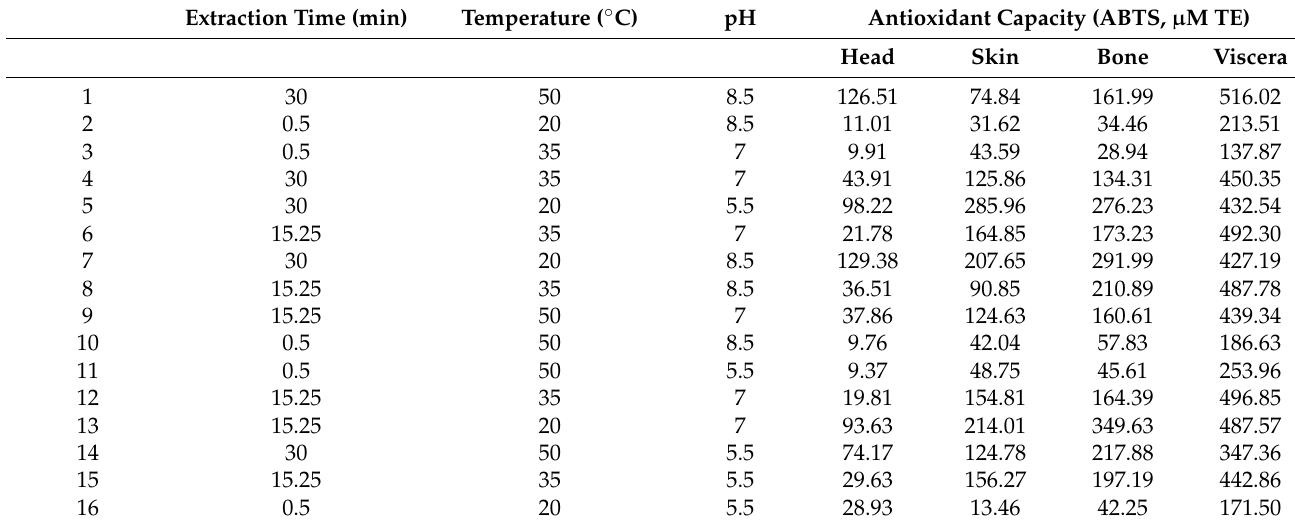
Table 5. Antioxidant capacity values obtained by ABTS assay ( µ M TE) from sea bass side streams extracts using UAE at different extraction times (min), temperature ( ◦ C), and